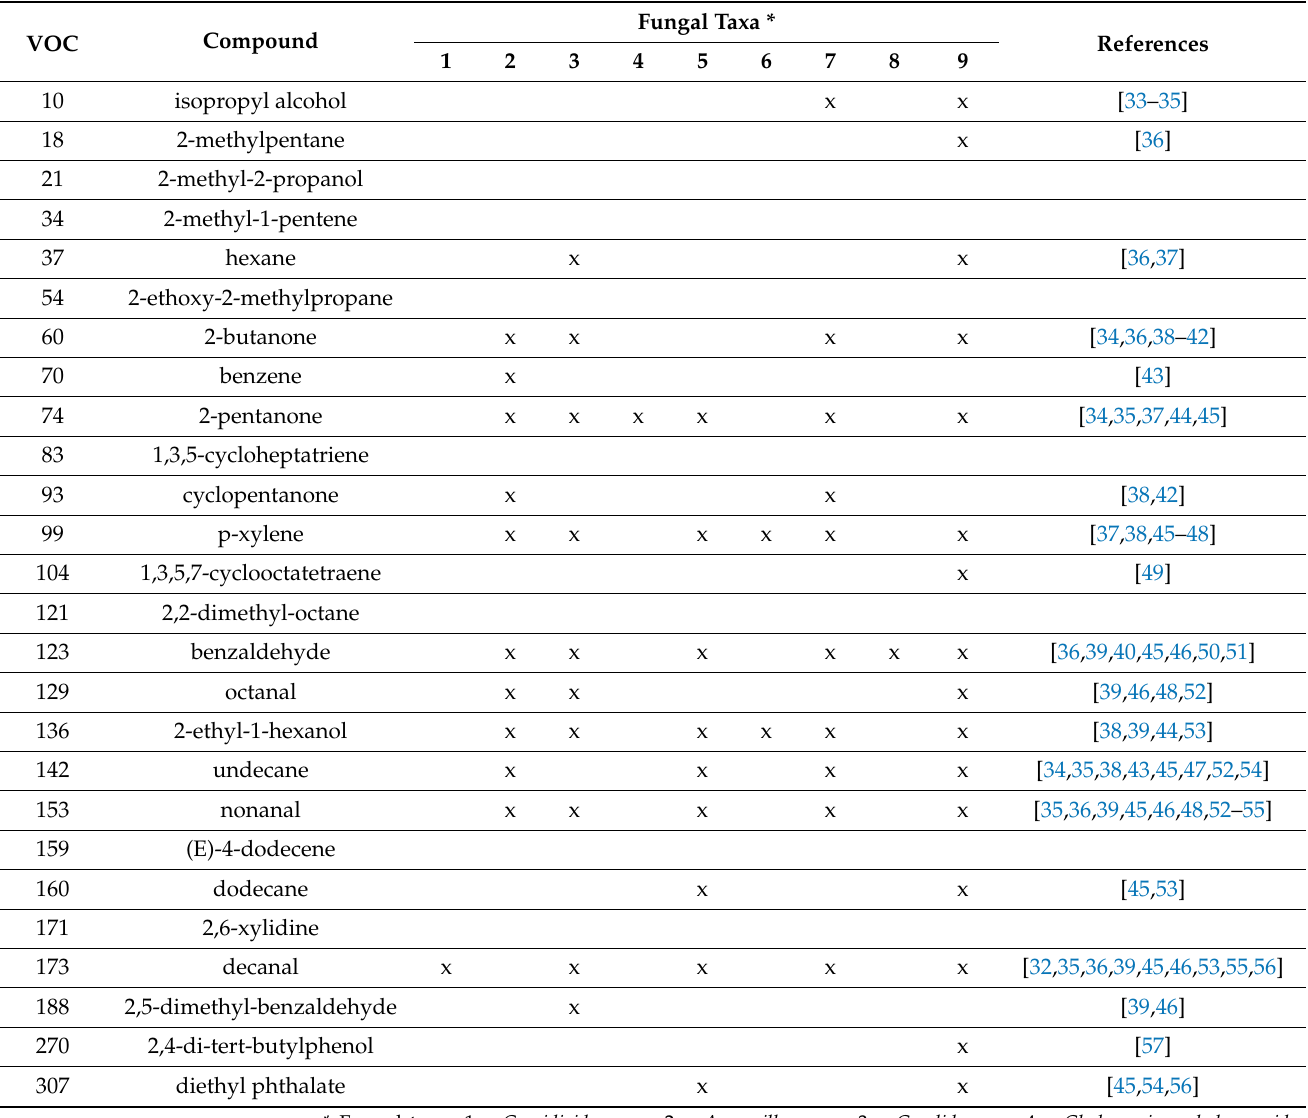
Table 1. Named volatiles detected in the BALF of Coccidioides -infected mice and previous reports in other fungal